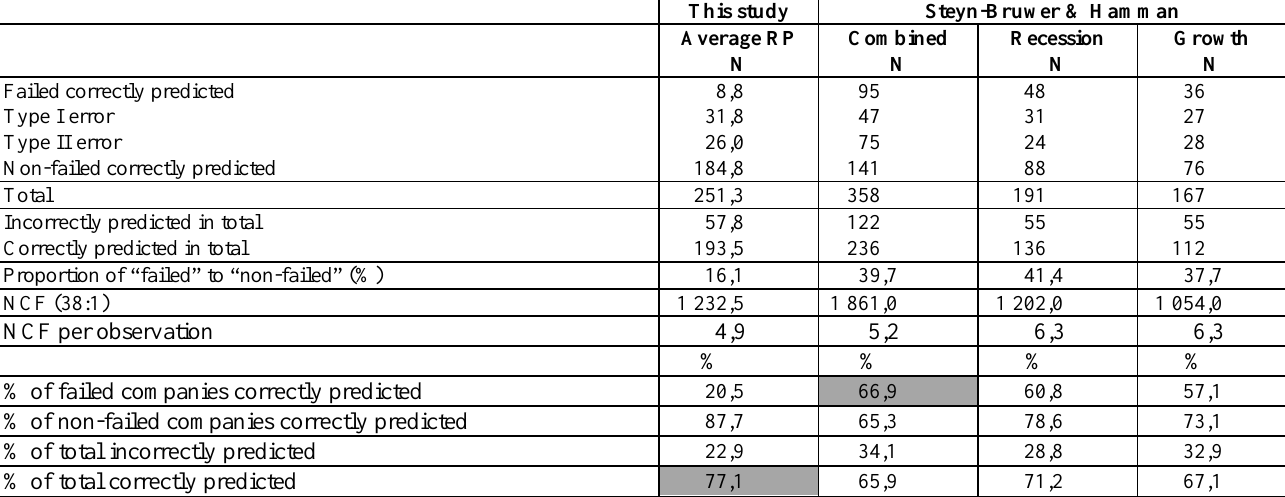
Table 4: Recursive partitioning results for Steyn-Bruwer and